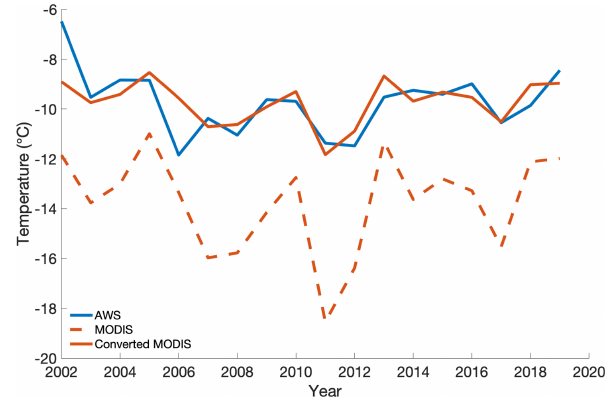
Figure 12. AWS temperatures, MODIS LSTs, and MODIS LSTs converted to air temperatures at Divide. Unconverted MODIS LSTs (dashed orange line) show a prominent offset from AWS measure- ments but overall agreement in years of high vs. low temperatures. MODIS LSTs converted to air temperatures by applying a simple linear regression (solid orange line) show much closer agreement with AWS temperatures (solid blue line). All temperatures are mean annual